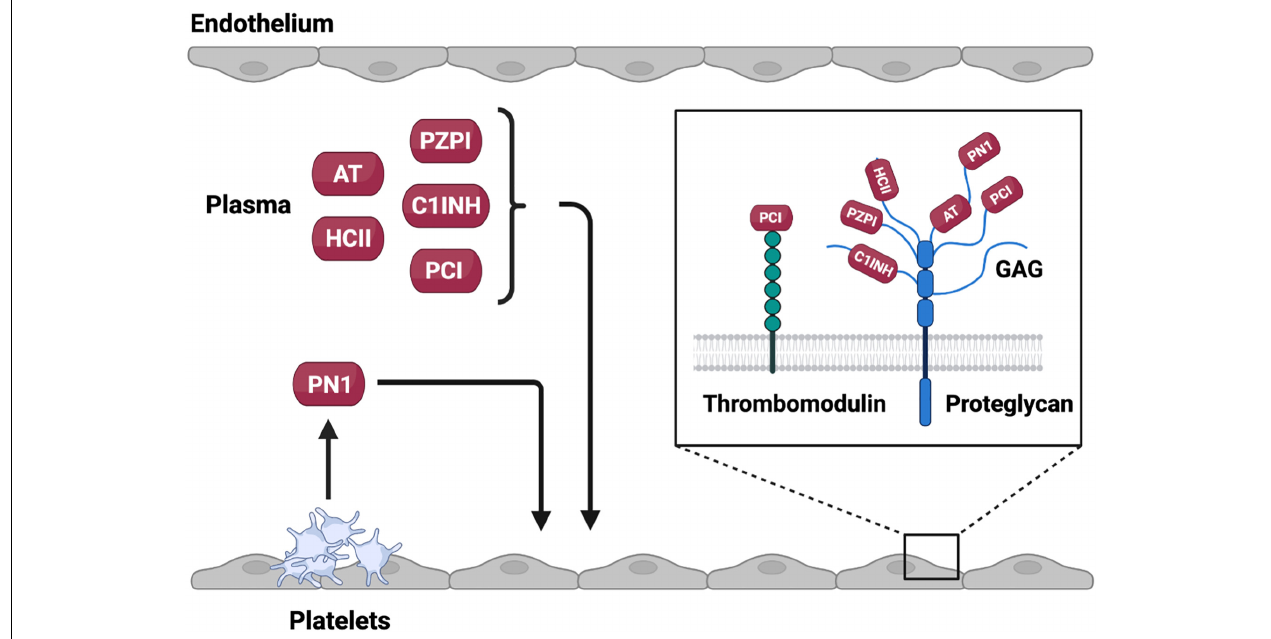
FIGURE 3 | Source and site of activity of anticoagulant SERPINs. Anticoagulant SERPINs AT, HCII, PZPI, C1INH, and PCI are present in the plasma whereas PN1 is stored in platelet alpha granules where it can be released on platelet activation. Anticoagulant SERPINs bind to glycosaminoglycans (GAGs) or protein cofactors on the endothelial surface that potentiate inhibition of target proteases. Created with BioRender.com.